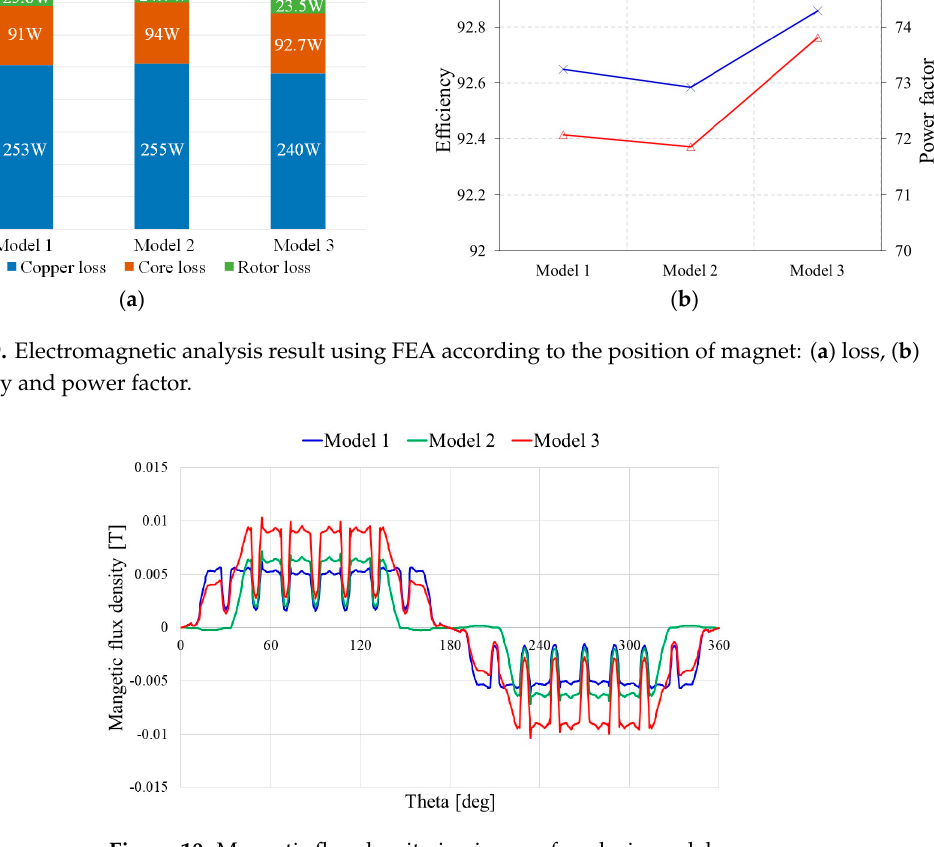
Figure 10. Magnetic flux density in air gap of analysis models.